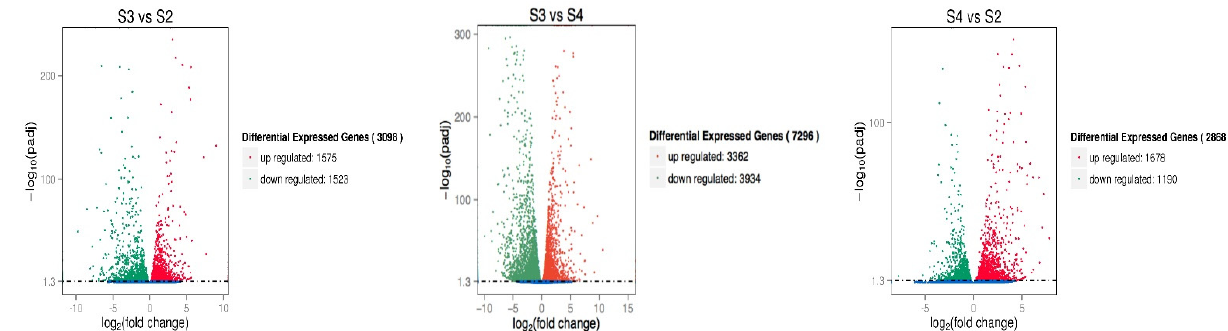
Figure 4. A. phaeospermum differentially expressed genes of 3 comparison groups in three periods S2–S4. Note: Red dots represent upregulated genes; green dots represent down regulated genes and blue dots represent nondifferentially expressed genes.